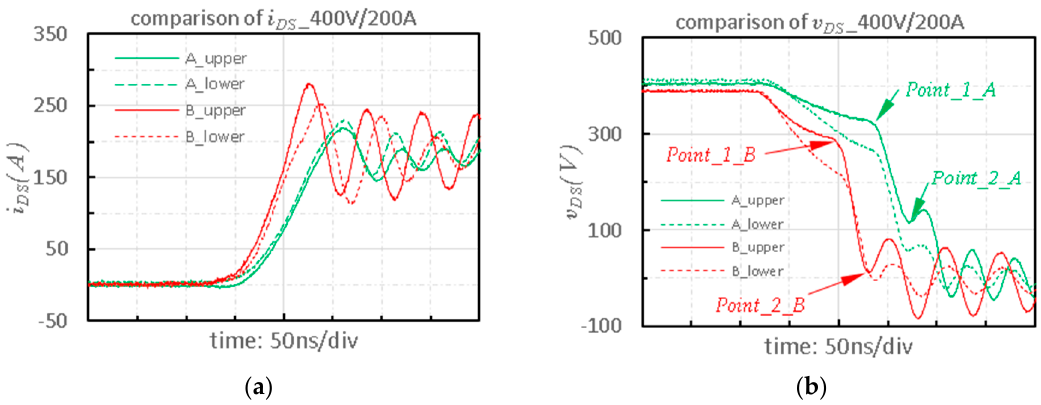
Figure 5. The comparison of turn-on transient waveforms of the modules with the same structure design but different power dies under condition of high 𝑉 (cid:3005)(cid:3005) : ( a ) waveform of 𝑖 (cid:3005)(cid:3020) , ( b ) waveform of 𝑣 (cid:3005)(cid:3020) .